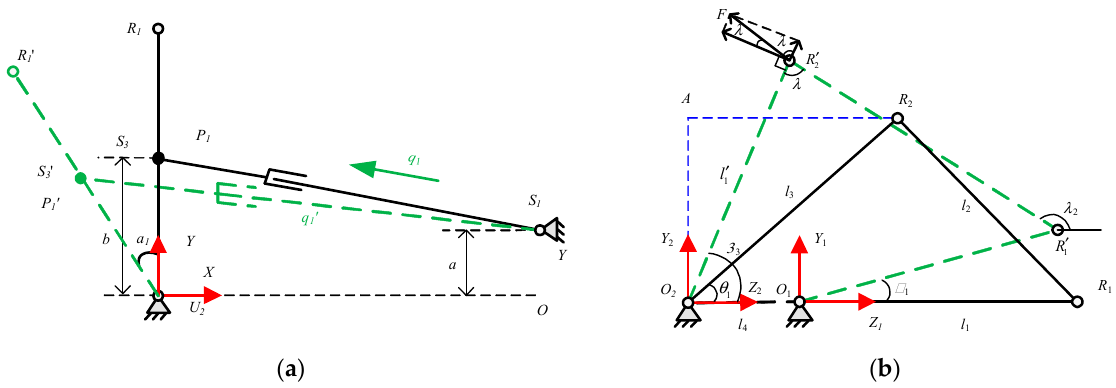
Figure 6. The schematic diagrams of the ( a ) input mechanism and ( b ) MCP joint mechanism.